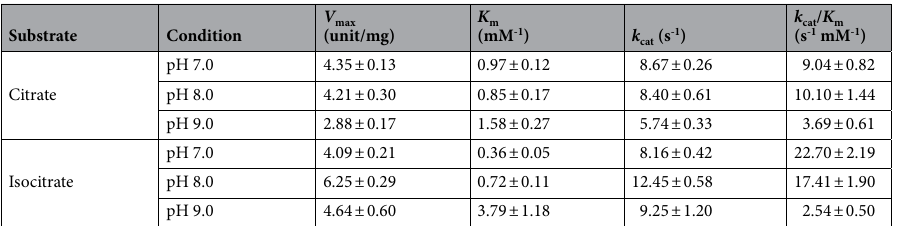
Table 4. Kinetic parameters of Sy AcnB. These were measured in Tris–HCl buffer pH 7.0, 8.0, and 9.0 at 45 °C. Mean ± standard deviation values were calculated from three independent experiments. The P -values between citrate and isocitrate calculated by Student’s t -test were listed in Table